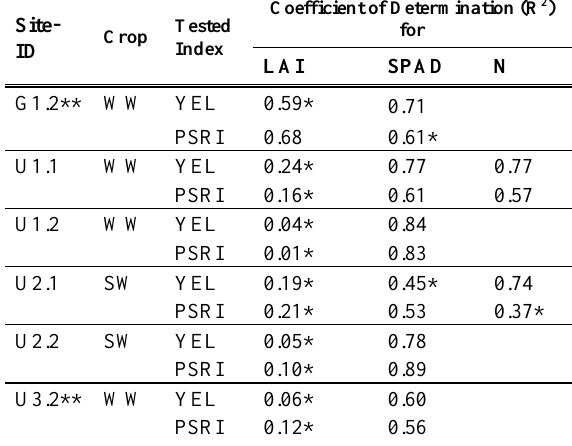
Table 3. Coefficient of determination of leaf area index (LAI), chlorophyll (SPAD) and nitrogen (N) concentration, Yellowness (YEL) vs. PSRI.